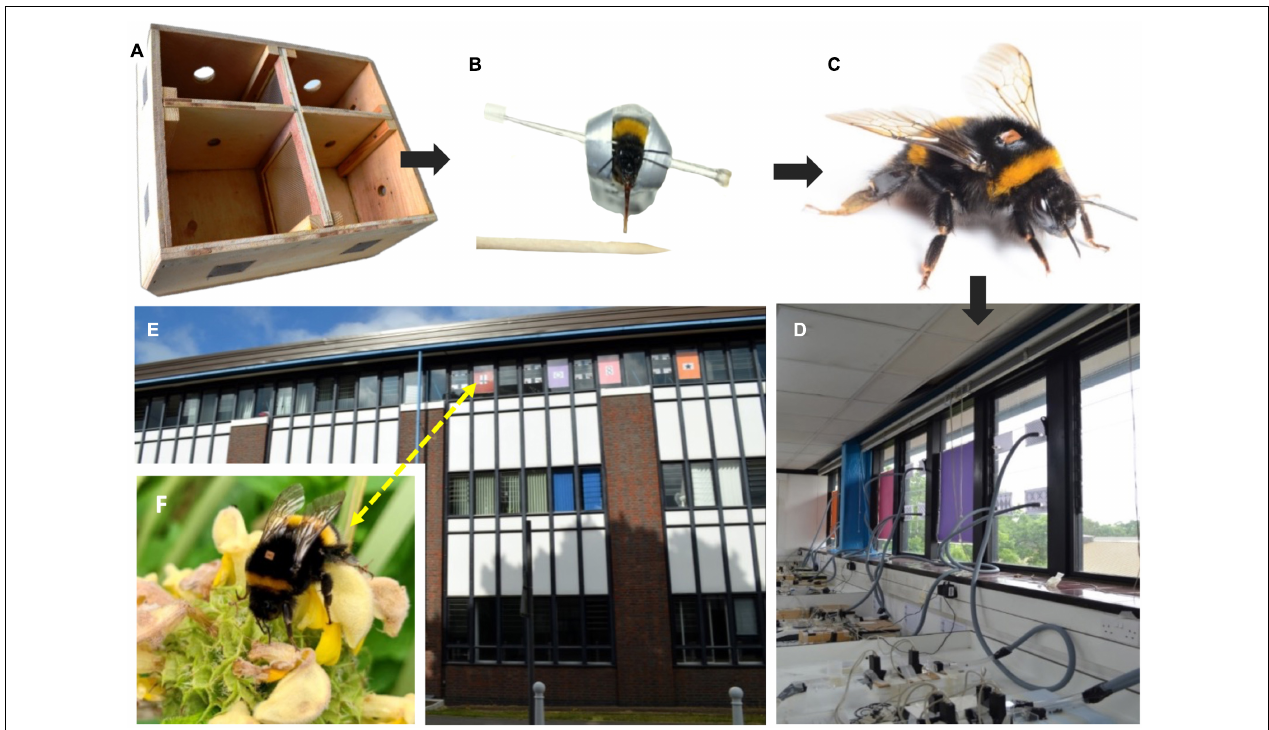
FIGURE 1 | | Diagram showing experimental setup. (A) Divided colony box with a mesh partition, which contained the split colonies (colourless, transparent lid removed for clarity). (B) Bees identified as foragers, based on frequency of foraging in an indoor foraging arena, were harnessed and tested on their olfactory learning ability using proboscis extension response (PER) conditioning paradigm. (C) Assessed individuals were tagged with an RFID tag to enable us to track their subsequent foraging performance. (D) After being assessed the bees were transferred to the (external) side of their divided colony box that was connected to the laboratory window. (E) Each window exit/entrance was marked with a unique pattern to assist retuning foragers in finding their colony. (F) The RFID reader system allowed us to record the foraging behaviour of the bees in the rural/urban landscape surrounding Royal Holloway University of London (Egham Hill, Egham TW20 0EX, United Kingdom). The RFID tag on the bee in image (F) has been added digitally for illustrative purposes. Photos (B,C) provided by Dylan Smith and Brian Cutting,